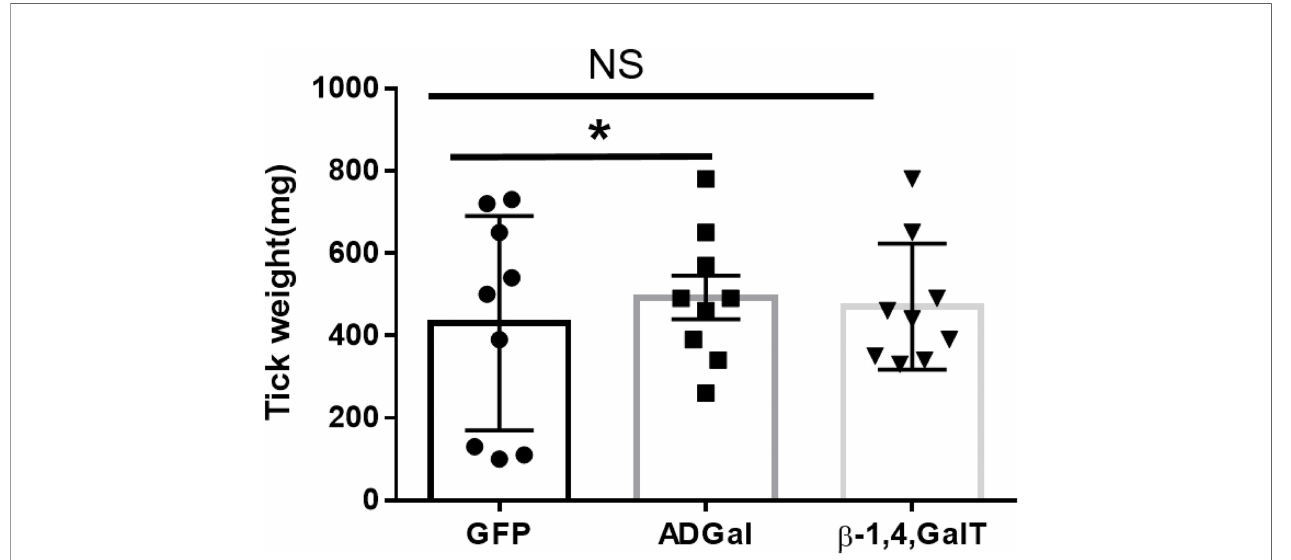
FIGURE 2 | Engorgement weights of ticks treated with dsRNA. Tick weights were taken from mass replete or forcibly removed ticks at four time-points during the bloodmeal after treatment with dsADGal ( a -galactosidase), ds b - 1,4-GT ( b -1,4 galactosyltransferase), or dsGFP (irrelevant control) double-stranded RNA (*P < 0.05, results are compared by students t-test with unequal variance, N=9; NS, Non-signi fi